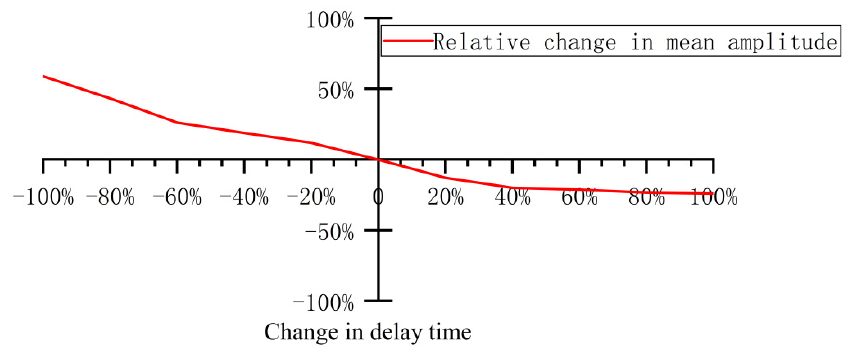
Figure 12. Sensitivity analysis of delay time values to amplitude averages.